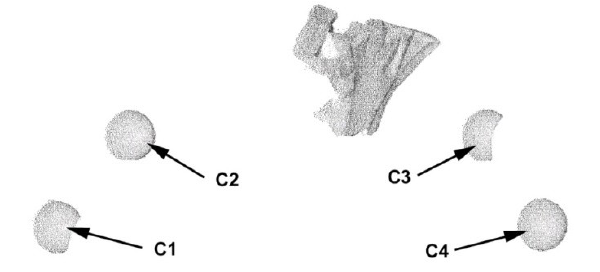
Fig. 4: the four registration spheres which have been the object of denoising through the NL-means approach and the dictionary learning of sparse coding